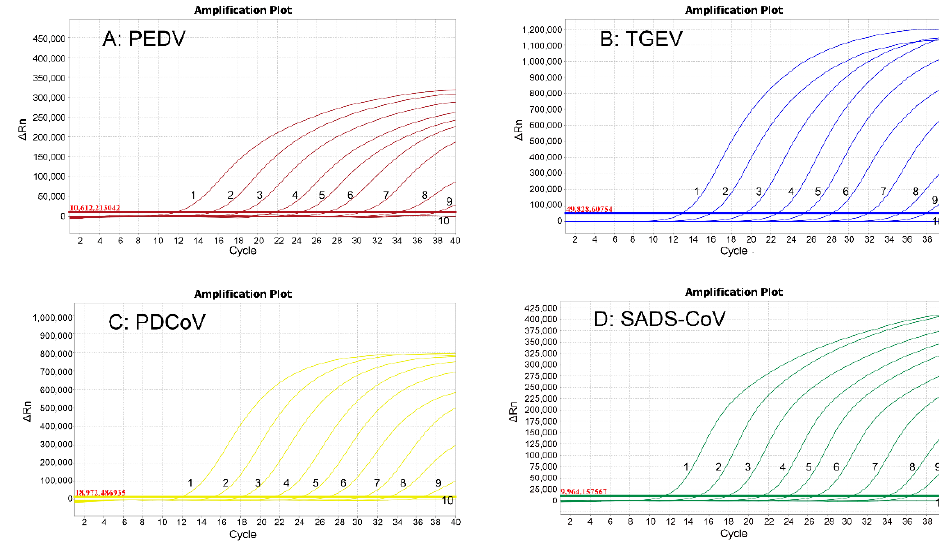
Figure 3. Sensitivity analysis. 1 – 10: 1.21 × 10 9 – 1.21 × 10 0 copies/μL (final reaction concentrations: 1.21